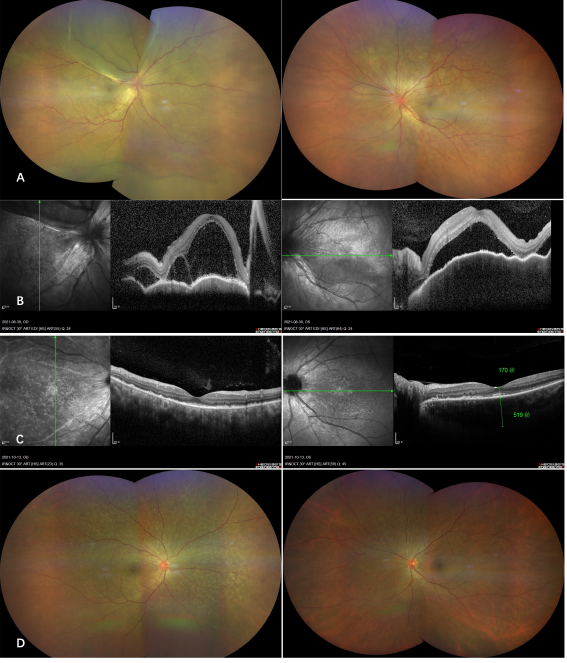
Figure 2. Acute onset of Vogt–Koyanagi–Harada disease after administration of inactivated COVID- 19 vaccine. Wide-field color fundus photography of a previous healthy woman who developed bilateral multiple serous retinal detachment 10 days following the first dose of the Sinopharm inactivated COVID-19 vaccine ( A ), corresponding to the OCT revealing intraretinal and subretinal fluid ( B ). The patient started on oral steroid with tapering dose, and the bullous retinal detachment resolved completely after 6 weeks of follow-up ( C , D ).